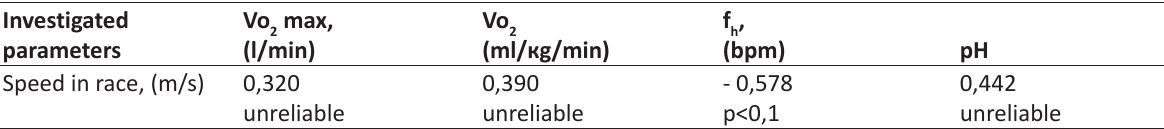
Table 2. Coefficients of correlation between the investigated parameters of the cardiorespiratory system of the body of athletes and the result in the race for 4 km